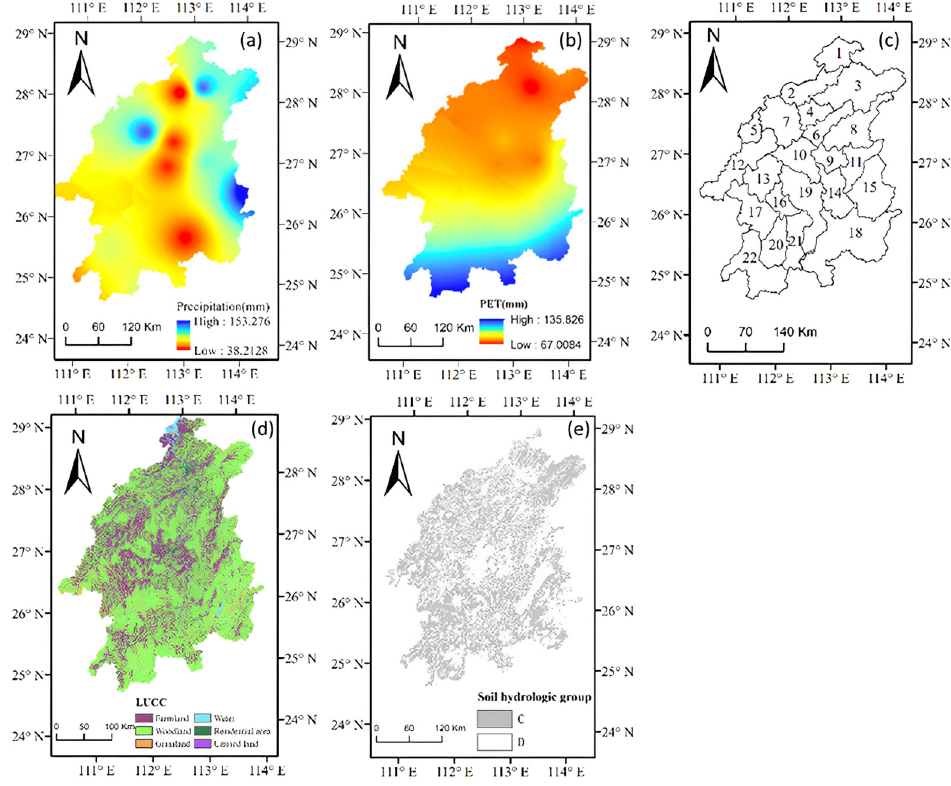
Figure 2. ( a ) Rainfall for January 2006. ( b ) Potential evapotranspiration for January 2006. ( c ) Sub- watershed. ( d ) Land-use map of the XRB in 2006. ( e ) Grouping charts for hydrological soils.